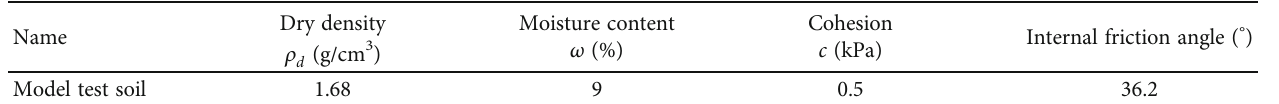
Table 2: Model soil parameters.